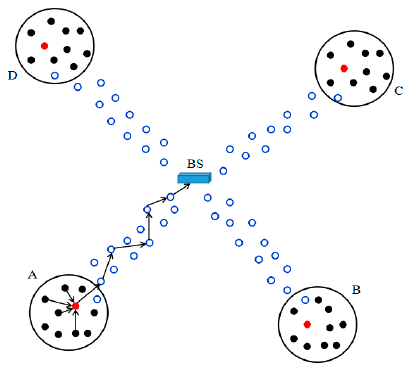
Figure 1. An example of a sensor network.